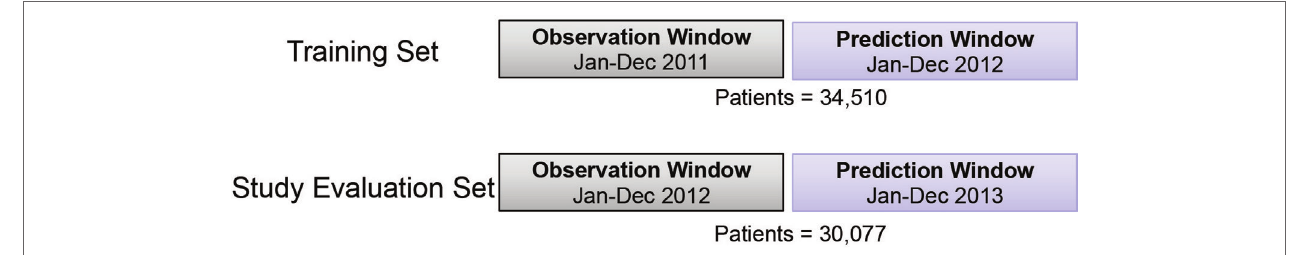
FigUre 1 | Illustration of training and study evaluation cohorts for the study